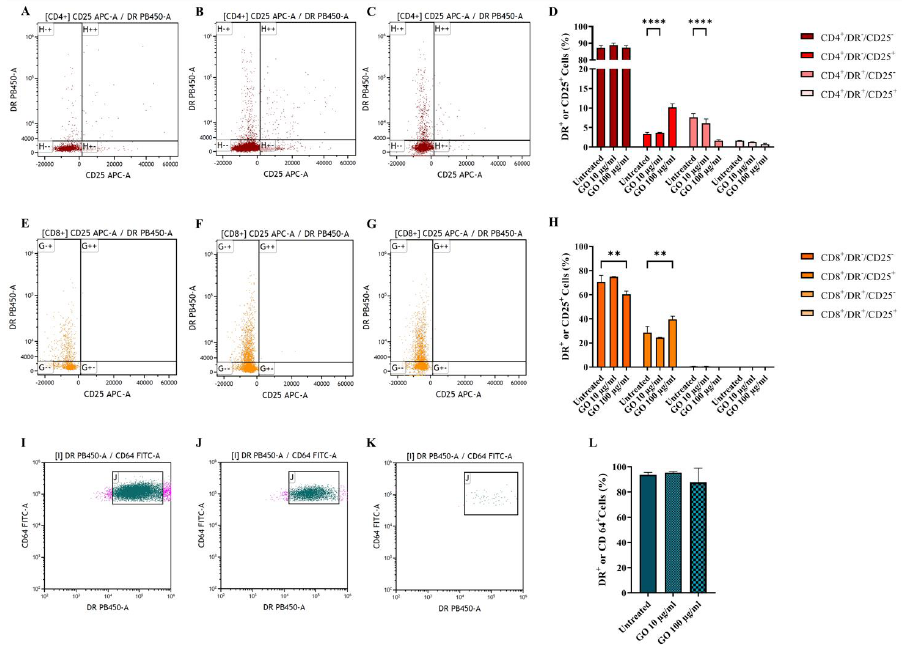
Figure 5. Graphene Oxide effect on cell activation. Activation of CD4+ ( A – C ), CD8+ ( E – G ) and CD64+ ( I – K ) populations was evaluated after 1 h incubation. Untreated cells ( A , E , I ), GO 10 µg/mL treated cells ( B , F , I ) and GO 100 µg/mL ( C , G , K ) after 1 h incubation. CD4+ activation was evaluated through DR PB450-A versus CD25 APC-A gating on CD4+ cells ( A – C ). CD8+ activation was evalu- ated through DR PB450-A versus CD25 APC-A gating on CD8+ cells ( E – G ). Monocyte activation was evaluated through CD64 FITC-A versus Side scatter SSC-A gating on CD64+ cells ( I – K ). Acti- vation of cells based on parental percentages is quantitatively represented as histograms showing average ± standard deviation ( D , H , L ). The presence of nano-material does not affect cellular activa- tion since, when exposed to GO, CD4+ and CD8+, cells show only an early activation phenotype, comparable with untreated cells ( p value, respectively, <0.0001 and =0.0014) while CD64+ alive cells show no sign of maturation. (** p value < 0.01; **** p value < 0.0001).